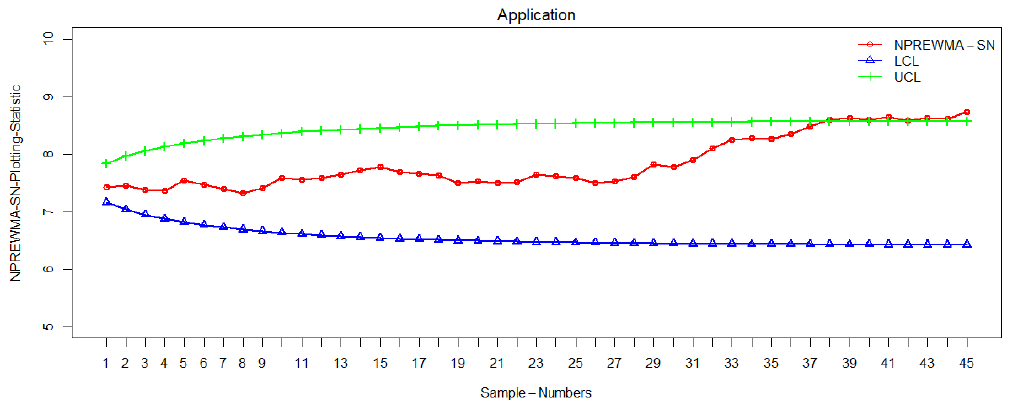
Figure 7. Real-life application of the proposed chart in a hard-bake manufacturing process.